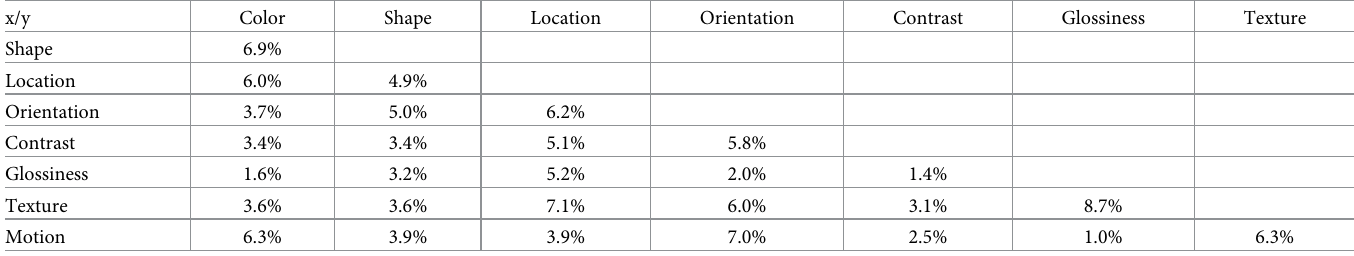
Table 4. Percentages of co-occurrence of specific visual deficits. How many patients who have performed both task x and y (in %) have deficits in both tasks. x/y Color Shape Location Orientation Contrast Glossiness